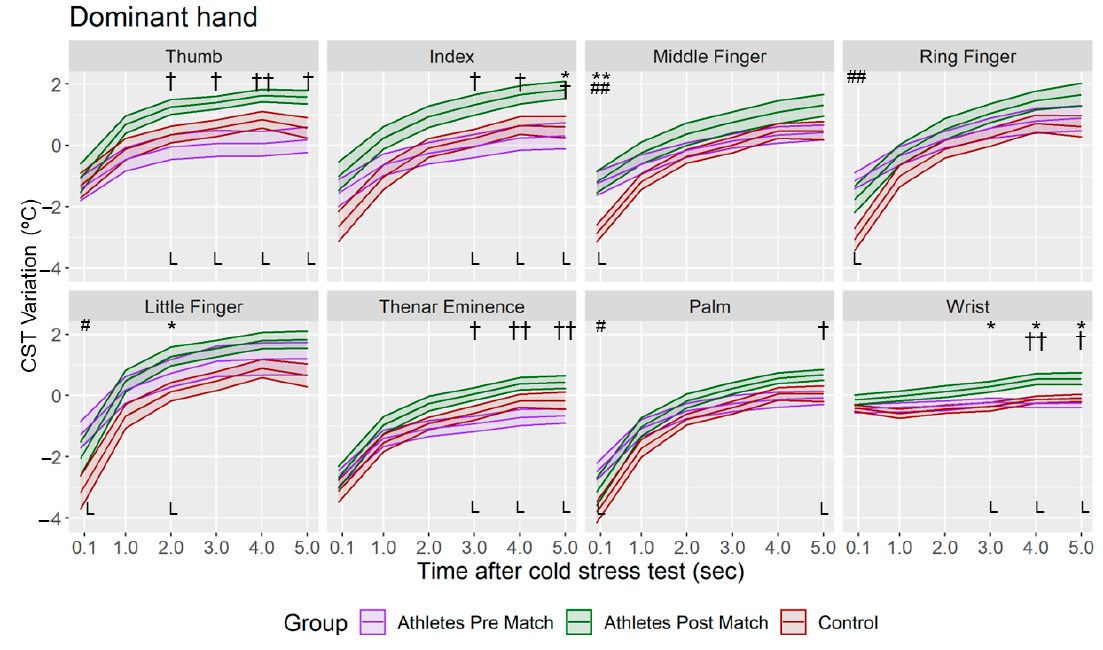
Figure 6. Mean and standard deviation of the CST variation in dominant hand for each minute after CST in all the groups. L = Large Effect Size. Difference between Athletes Group—Post Match and Athletes Group—Pre Match († p < 0.05; †† p < 0.01); Difference between Control Group and Athletes Group—Post Match (* p < 0.05; ** p < 0.01); Difference between Control Group and Athletes Group—Pre Match (# p < 0.05; ## p < 0.01).